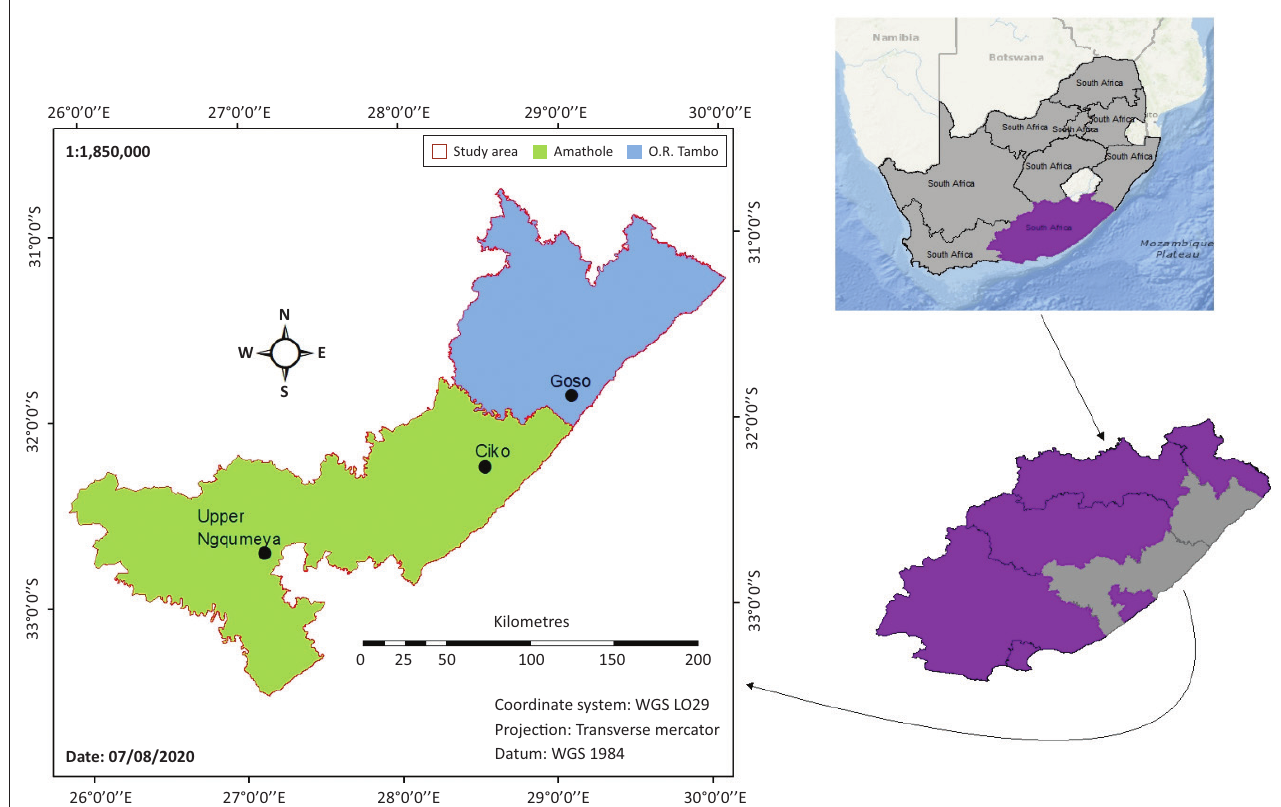
FIGURE 1: South African map showing the study